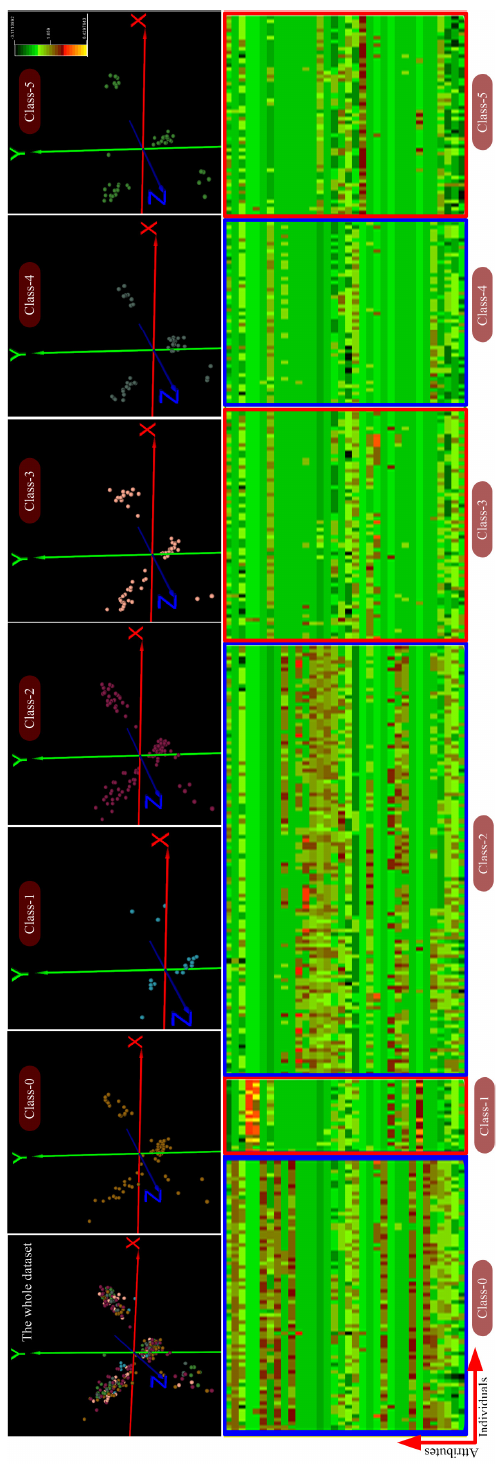
Figure 3. DS3 dataset (Dermatology Dataset). A 3D-scatterplot is shown at the top of the figure where each point represents a column (an individual) of the dataset showed as a heatmap at the bottom. The dimension of the dataset was reduced to three components by using principal component analysis. In addition, points belonging to each class are shown in different colors. The heatmap corresponding to the same dataset is shown at the bottom of the figure. Each class of the dataset is framed in a box. The color bar shown at the top represents the color scale used in the